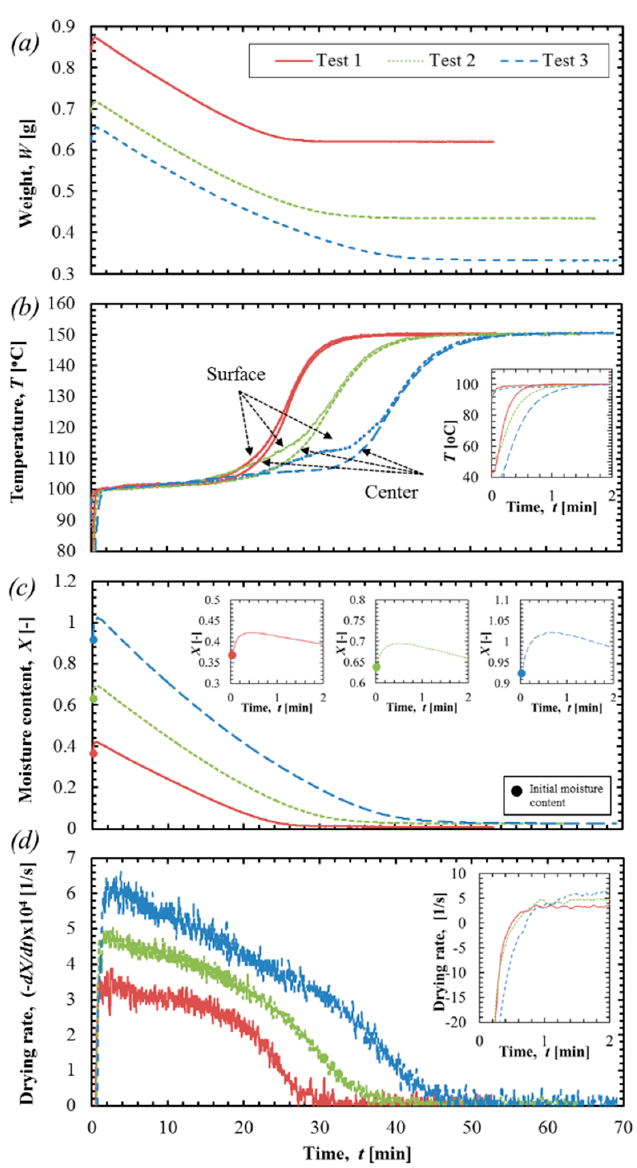
Figure 5. Exemplary drying characteristics of Sample T1 in superheated steam: 10 mm sample used in test temperature at 150 °C, change in: ( a ) weight; ( b ) temperature profiles; ( c ) moisture content; and ( d ) drying rate.